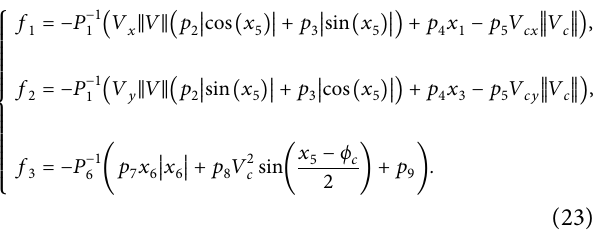
, x , x using 1 d 2 d 3 d